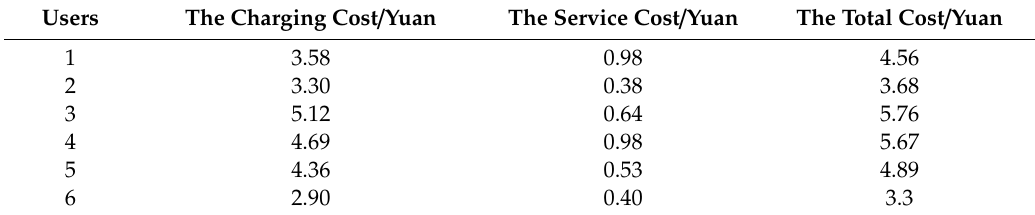
Table 2. Charging cost of each charging